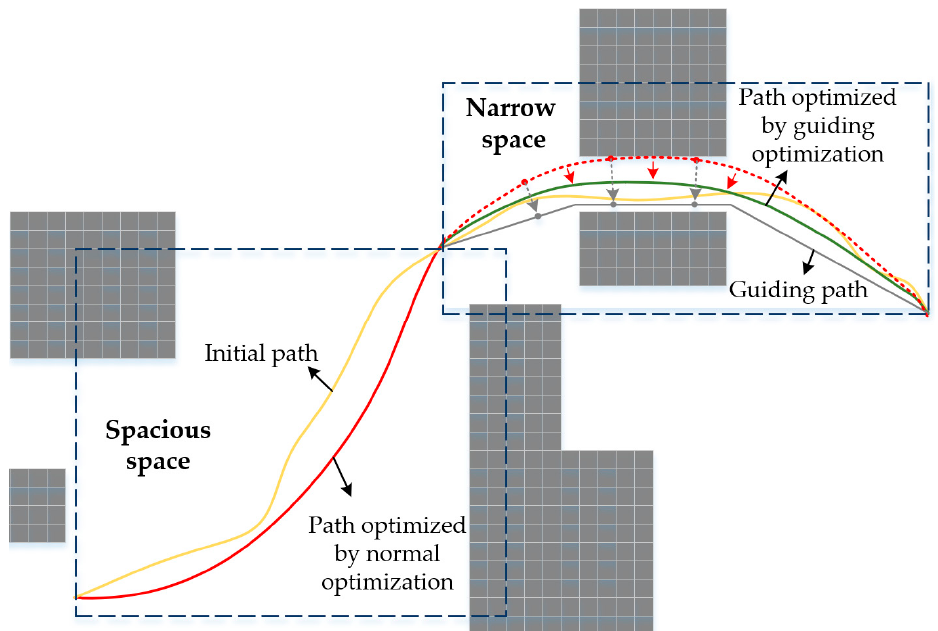
Figure 7. Trajectories are optimized by different optimization modes according to the different environments. The guiding path is the path generated in Section 2.2.1 and the initial path is generated by GKPS in Section 2.2.3.